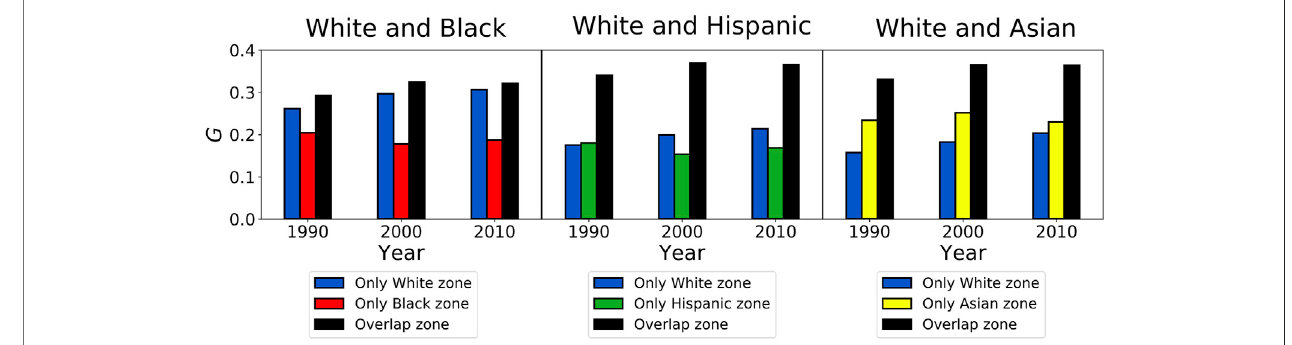
FIGURE4 | Gini coef fi cient forthe years of1990,2000, and 2010.Gini coef fi cientin theHD only zones and the Overlap zones tostudy segregation between white and black, white and Hispanic, and white and Asian.